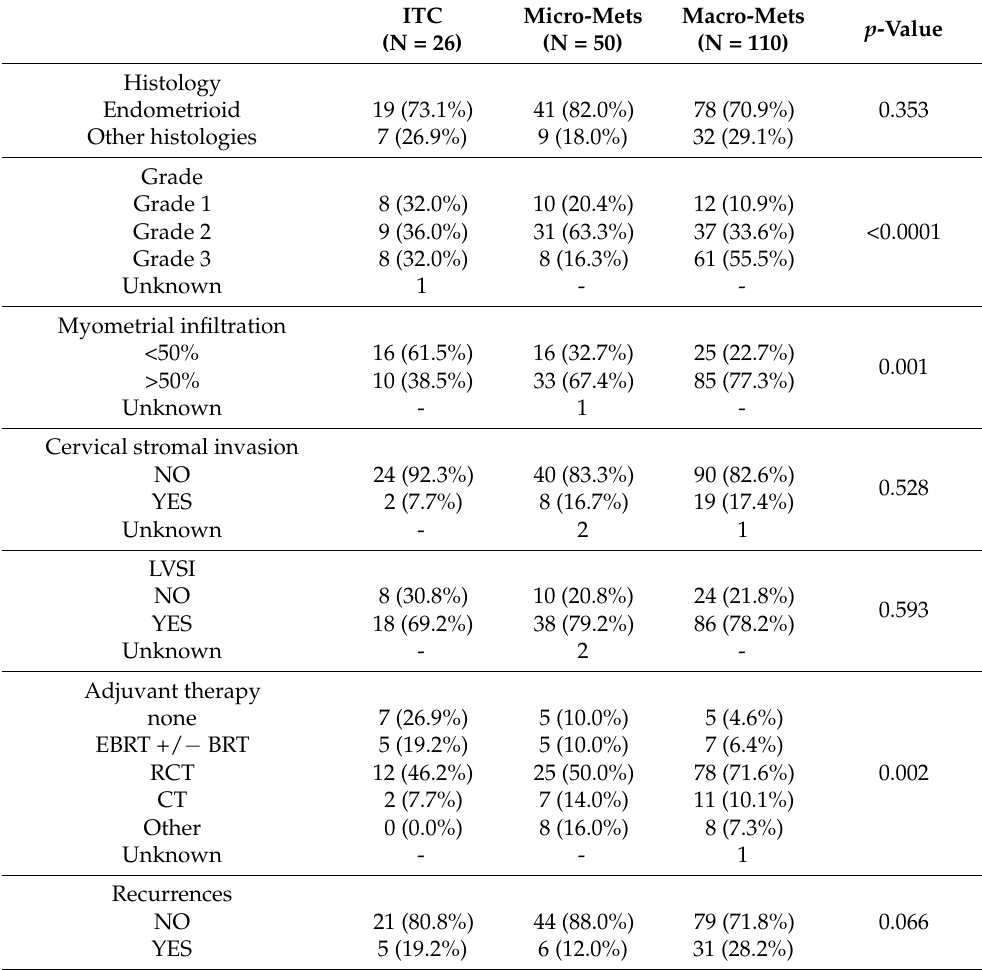
Table 2. Baseline characteristics of patients with positive lymph nodes (LNs) (N =